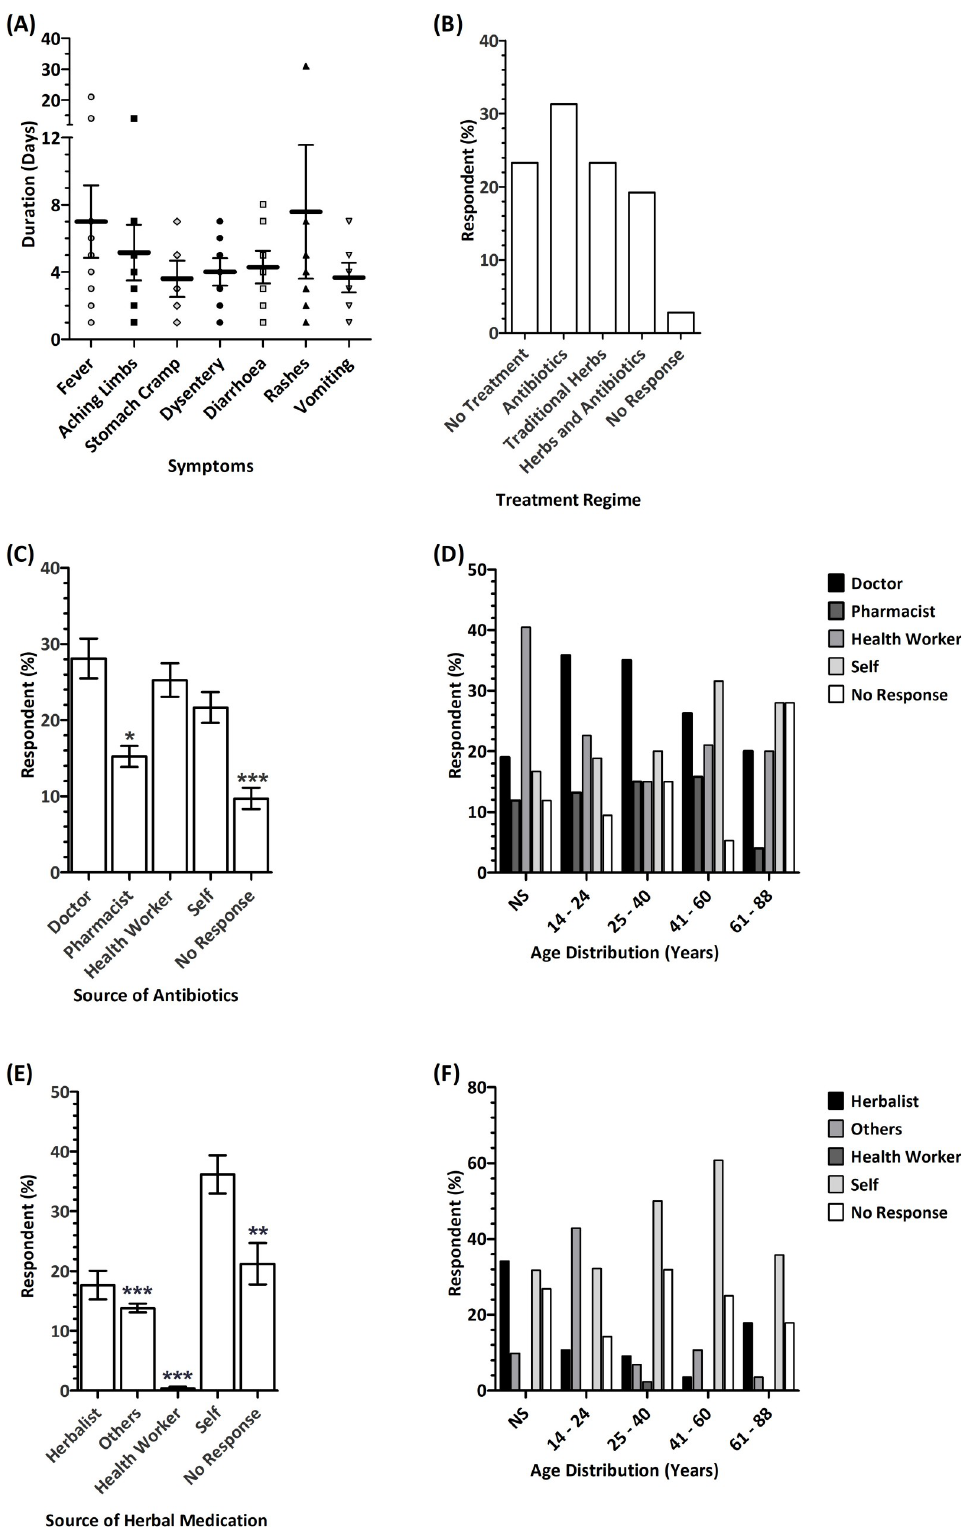
Fig 1. Reported symptoms, treatment regimens and sources of antibiotics and herbal medications. (A) Duration of reported symptoms of fever, aching limbs, stomach cramps, dysentery, diarrhoea, rash, and vomiting. (B) Treatment